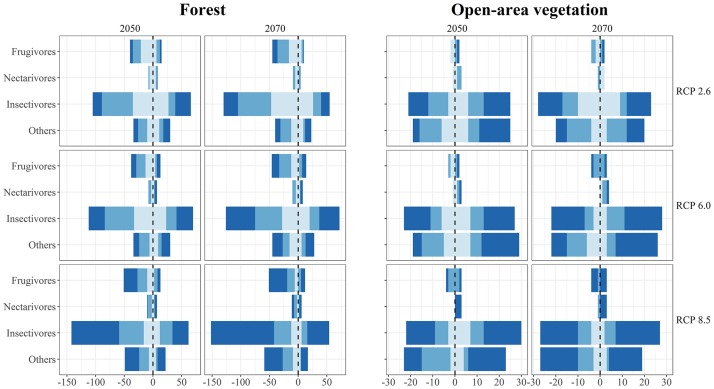
Potential climate change effects on forecasted occurrence area per species.Negative values represent the number of species predicted to lose suitable habitats under different scenarios at each guild class. Positive values represent the number of species predicted to gain suitable habitat. Light blue: ≥20%, blue: ≥ 50%, and dark blue: ≥ 90%.